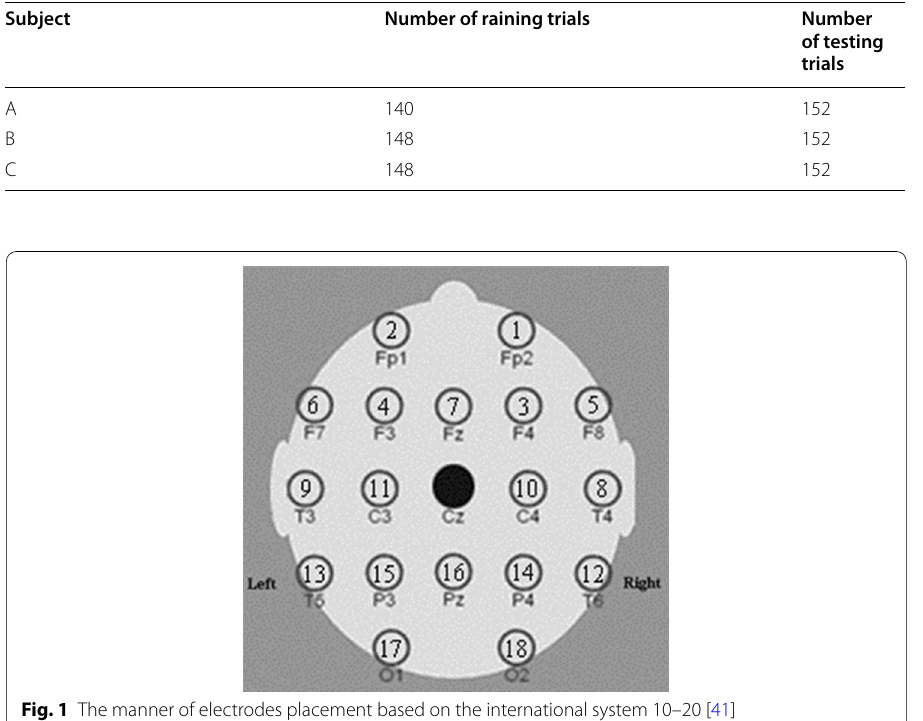
Fig. 1 The manner of electrodes placement based on the international system 10–20